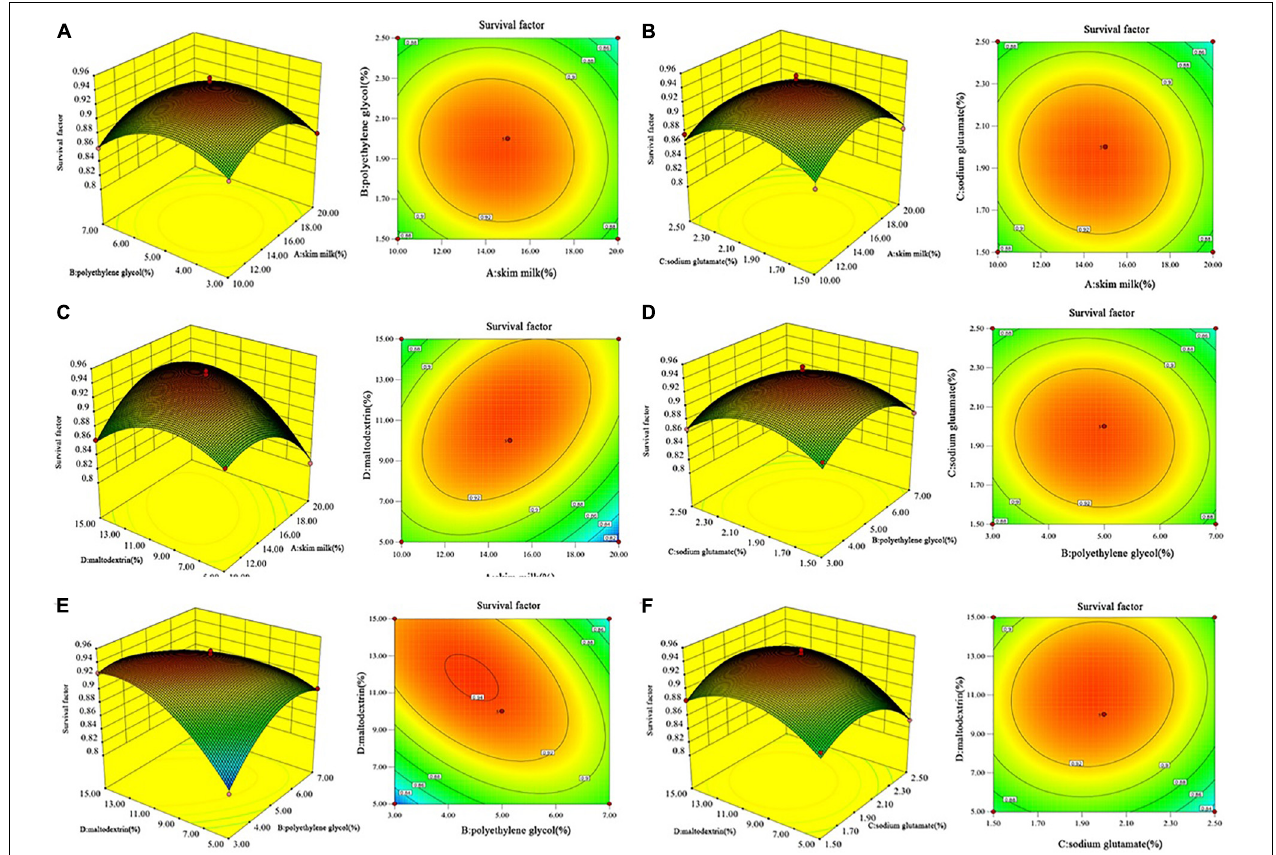
FIGURE 2 | Response surface and contour plots describing the interactive effects of (A) skim milk + polyethylene glycol, (B) skim milk + sodium glutamate, (C) skim milk + maltodextrin, (D) polyethylene glycol + sodium glutamate, (E) polyethylene glycol + maltodextrin, and (F) sodium glutamate + maltodextrin on the survival factor of the artificial starter culture.